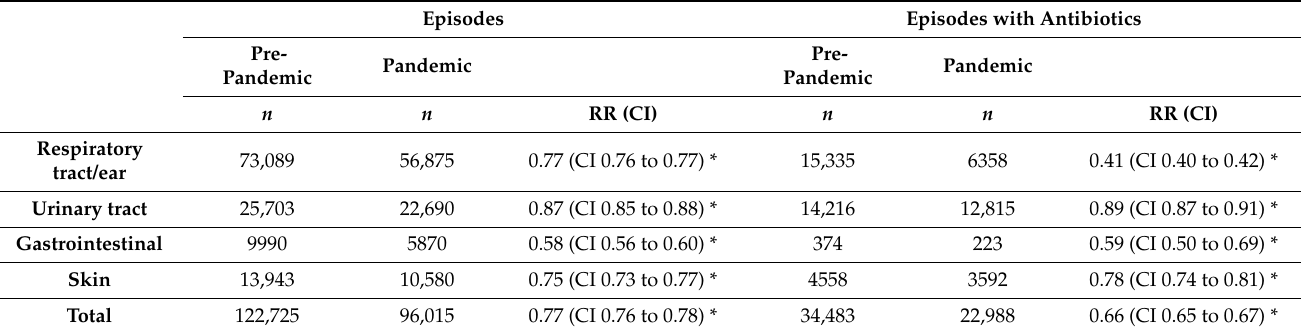
Table 1. Numbers of disease episodes per infection type in total and with antibiotic prescription for respiratory/ear, urinary tract, gastrointestinal and skin infections, pre-pandemic and in the first pandemic